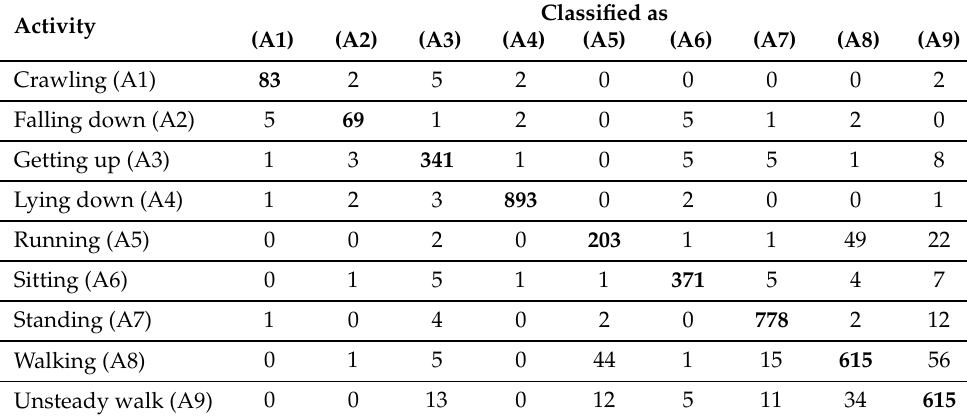
Table 7. Classification confusion matrix for the activity detection on the test